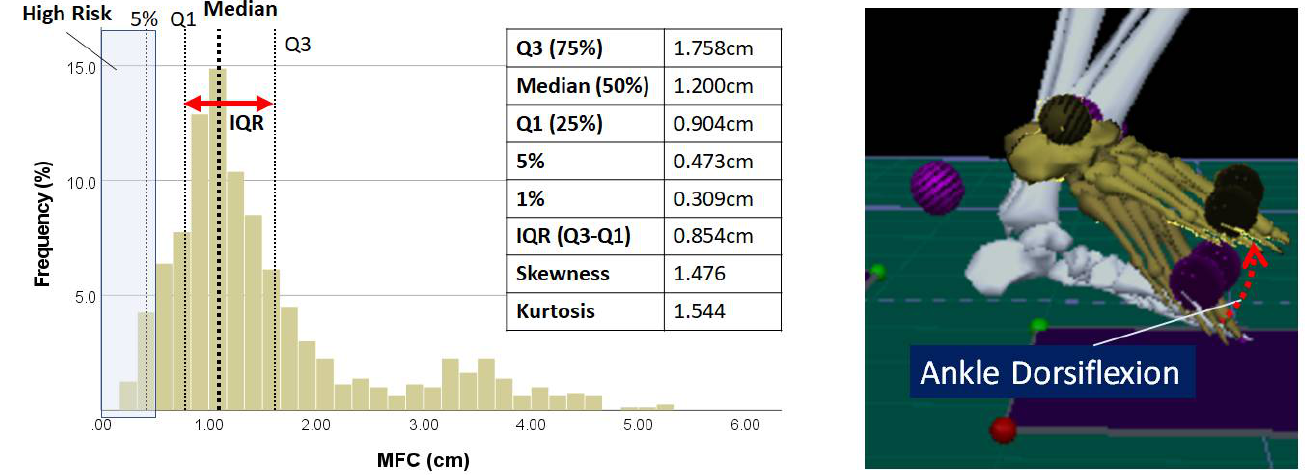
Figure 3 . ( Left ) MFC histogram description, IQR = interquartile range, Q1 = 25th percentile, Q3 = 75th percentile; ( right ) illustration of ankle dorsiflexion to increase MFC.